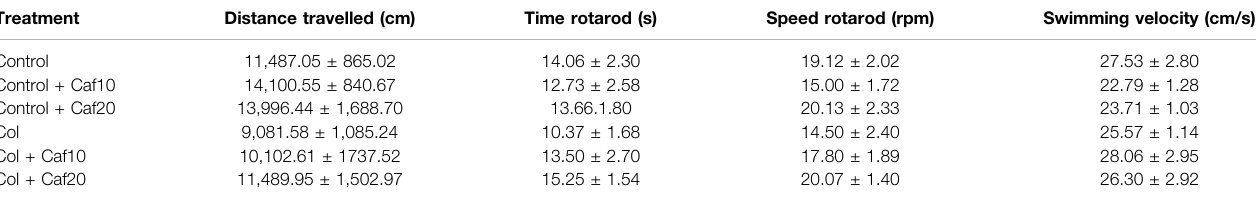
TABLE 1 | Motor activity was not affected in any of the groups under study.